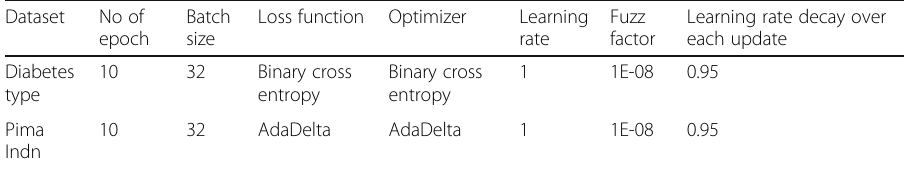
Table 5 Hyper parameter